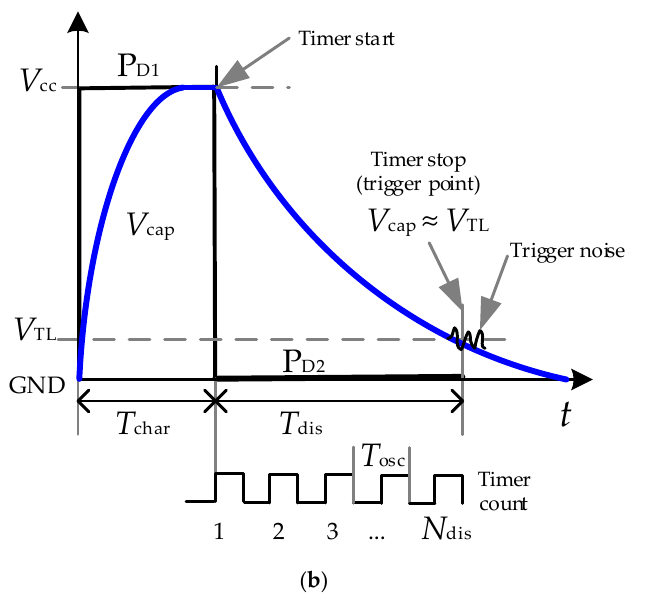
Figure 2. ( a ) DIC to measure the FSR variations (∆ R s ) caused by heartbeats; ( b ) digital state of P D 1 and P D2 and the voltage across C during each measurement of R s .